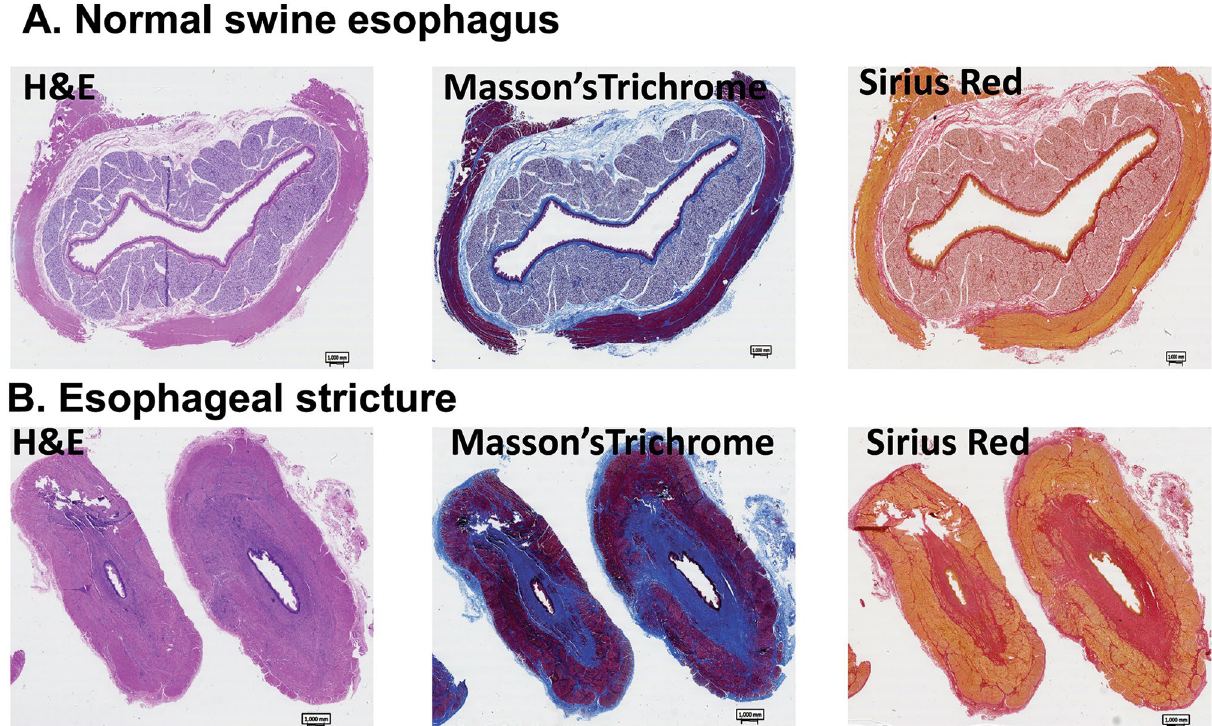
Figure 6. Histologic evidence of fibrosis at site of stricture formation. ( A ) Cross section of esophagus showing normal anatomy. Histologic evaluation shows no inflammatory changes or fibrosis. ( B ) Cross section of APC- induced esophageal stricture showing advanced fibrosis. H&E staining shows significant fibrosis of the lamina propria and submucosa (confirmed by Masson’s trichrome and Sirius Red). Note the significant narrowing of the lumen caused by APC-induced